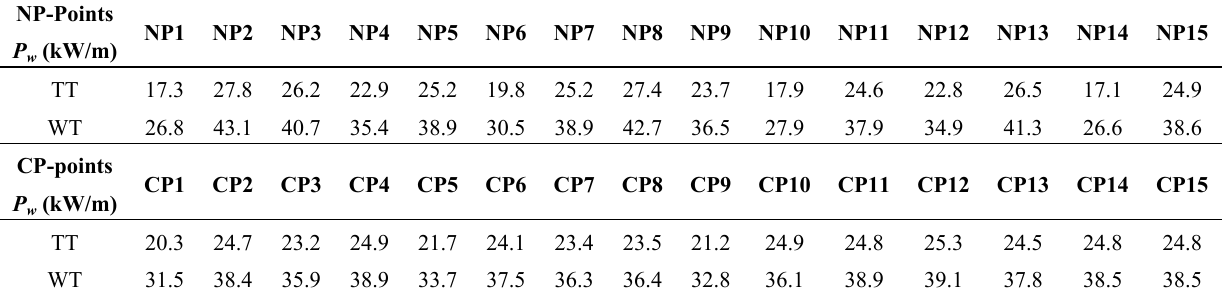
Table 4. Portuguese nearshore, average values of the wave power in kW over meter of wave front resulted from simulations with SWAN performed for the time interval 2009–2011, structured in total TT and winter time WT, respectively.